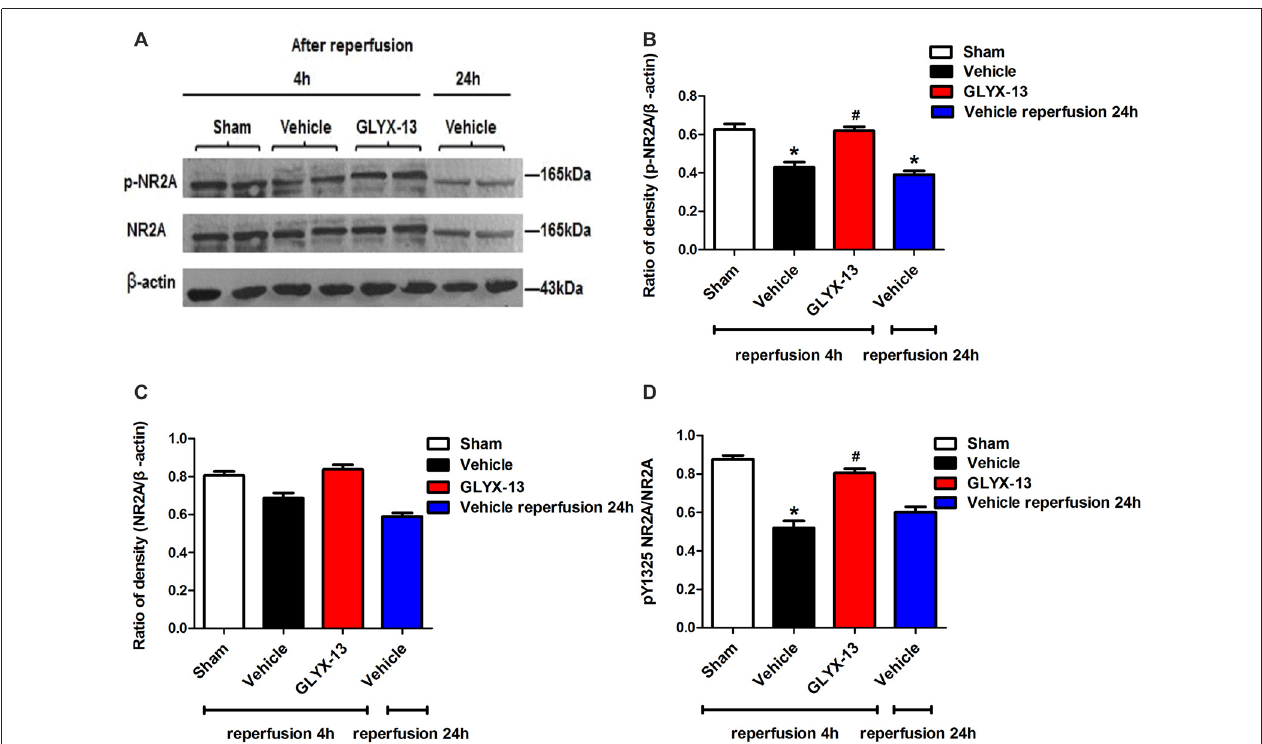
FIGURE 6 | GLYX-13 increased the expression of pY1325 NR2A 4 h after reperfusion. (A) Representative images of western blot. The intensity of each band was quantified by image j and normalized in relation to β -actin. (B–D) Statistical analysis of densitometric data from indicated experimental groups. The values are expressed as mean ± SEM, n = 3 independent experiments. One-way ANOVA and Newman-Keuls post test, ∗ p < 0.05, vs. Sham; # p < 0.05, vs.